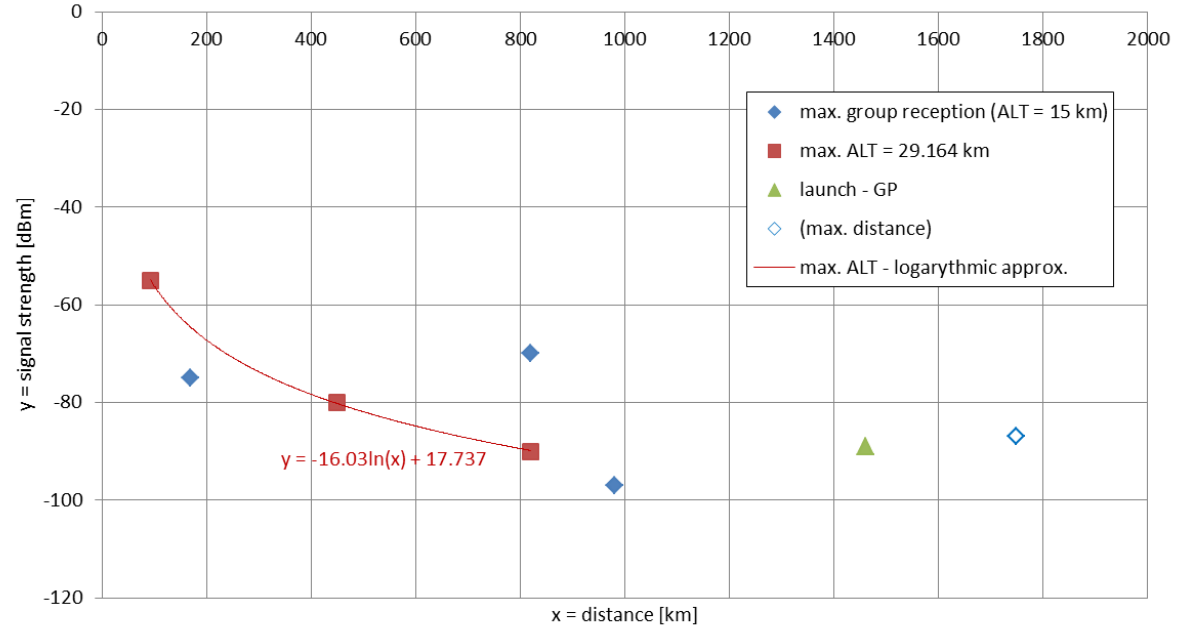
Figure 8. The registered signal levels on different distances from the launch site.